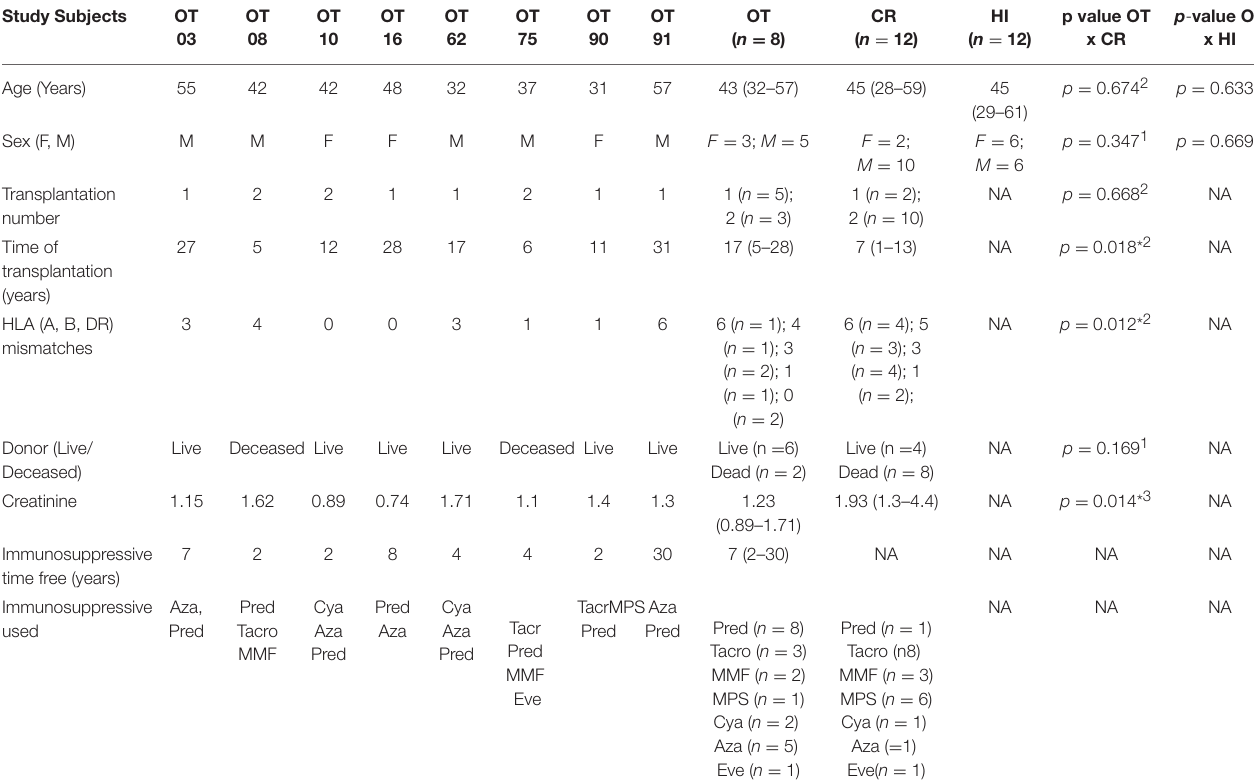
TABLE 1 | Demographic and clinical data of study